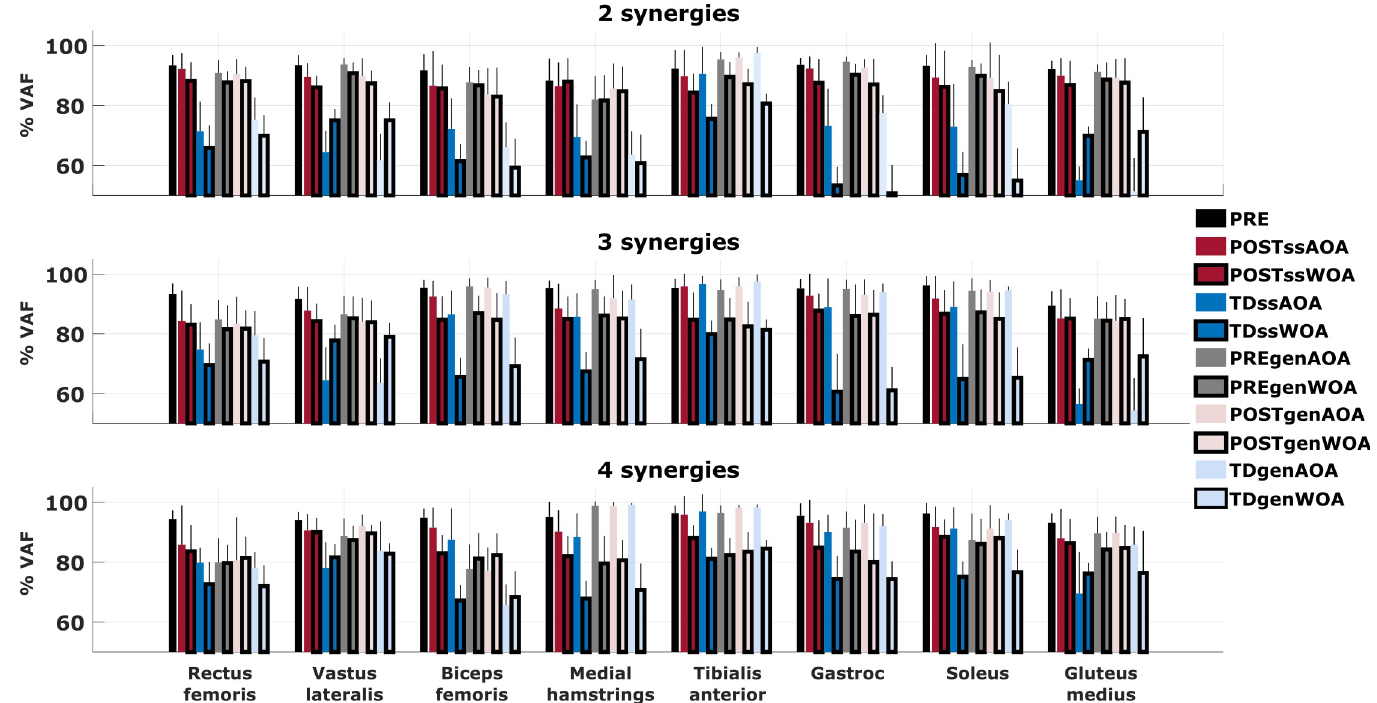
Fig 6. VAF computed independently for each of the analyzed muscles. Results from the EMG reconstructions using both subject-specific and generic synergies with both approaches, reported separately for each muscle. ss refers to the use of subject–specific synergies, gen to the use of generic synergies. AOA refers to the Activation Optinization Approach, WOA to the Weight Optimization Approach. Values for VAF PRE are defined during synergy extraction with